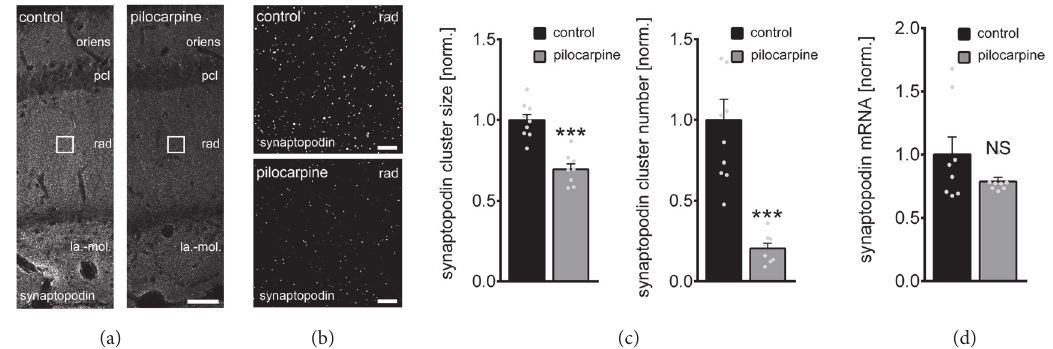
Figure 2: Pilocarpine-induced status epilepticus (SE) affects synaptopodin clusters in CA1 stratum radiatum. (a–c) Synaptopodin cluster sizes and numbers were assessed in CA1 stratum radiatum of anatomically matched coronal sections containing the dorsal hippocampus from pilocarpine- or vehicle-only-treated animals. 𝑁 control = 10 hippocampal slices of 5 animals, 𝑁 pilocarpine = 8 hippocampal slices of 4 animals; both hippocampi in each animal analyzed; averaged values from 3 images obtained from each slice (stratum oriens, oriens; stratum pyramidale, pcl; stratum radiatum, rad; stratum lacunosum-moleculare, la.-mol.). Values normalized to control. Gray dots indicate individual data points (one data point outside the axis limits for control synaptopodin cluster number). Mann-Whitney test; ∗∗∗ 𝑃 < 0.001 . Scale bars, in (a) 50 𝜇 m, in (b) 4 𝜇 m. (d) Synaptopodin mRNA levels are not significantly changed after single episode of SE. The results are normalized to HPRT gene expression within the same cDNA sample and are represented as the relative levels of the mean ± SEM versus control. 𝑁 = 8 hippocampi from 8 animals of each group. Mann-Whitney test; 𝑃 = 0.63 , NS, not significant